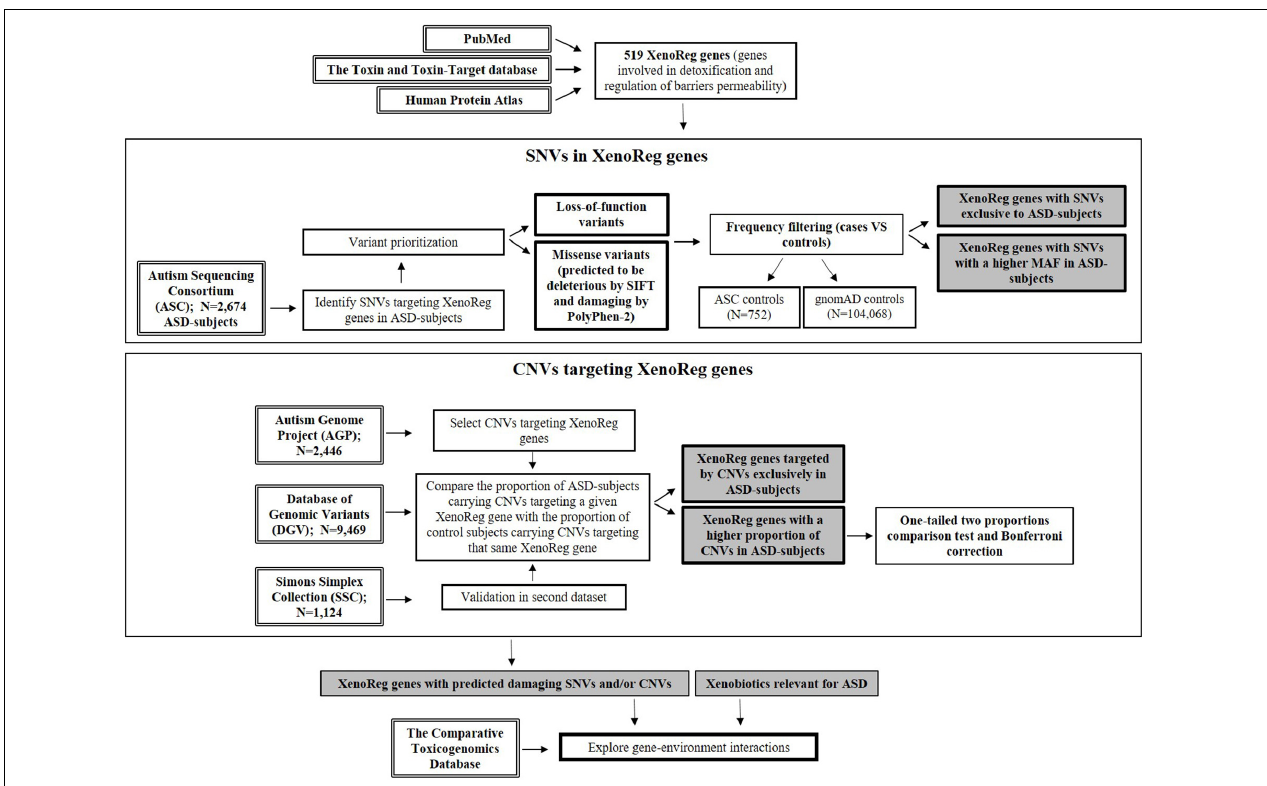
FIGURE 1 | Flowchart resuming the workflow of this study. Genes involved in detoxification and regulation of barriers permeability—XenoReg genes—were identified through PubMed and databases (The Human Protein Atlas and the Toxin and Toxin-Target Database). Large population datasets were interrogated for the presence of predicted damaging SNVs and CNVs in XenoReg genes, in individuals with ASD. The Comparative Toxicogenomics Database was queried to identify interactions between high evidence XenoReg genes and xenobiotics previously implicated in the disorder. ASD, Autism Spectrum Disorder; CNVs, Copy Number Variants; MAF, Minor Allele Frequency; SNVs, Single Nucleotide Variants; XenoReg genes, genes involved in regulation of detoxification and physiological barriers permeability to